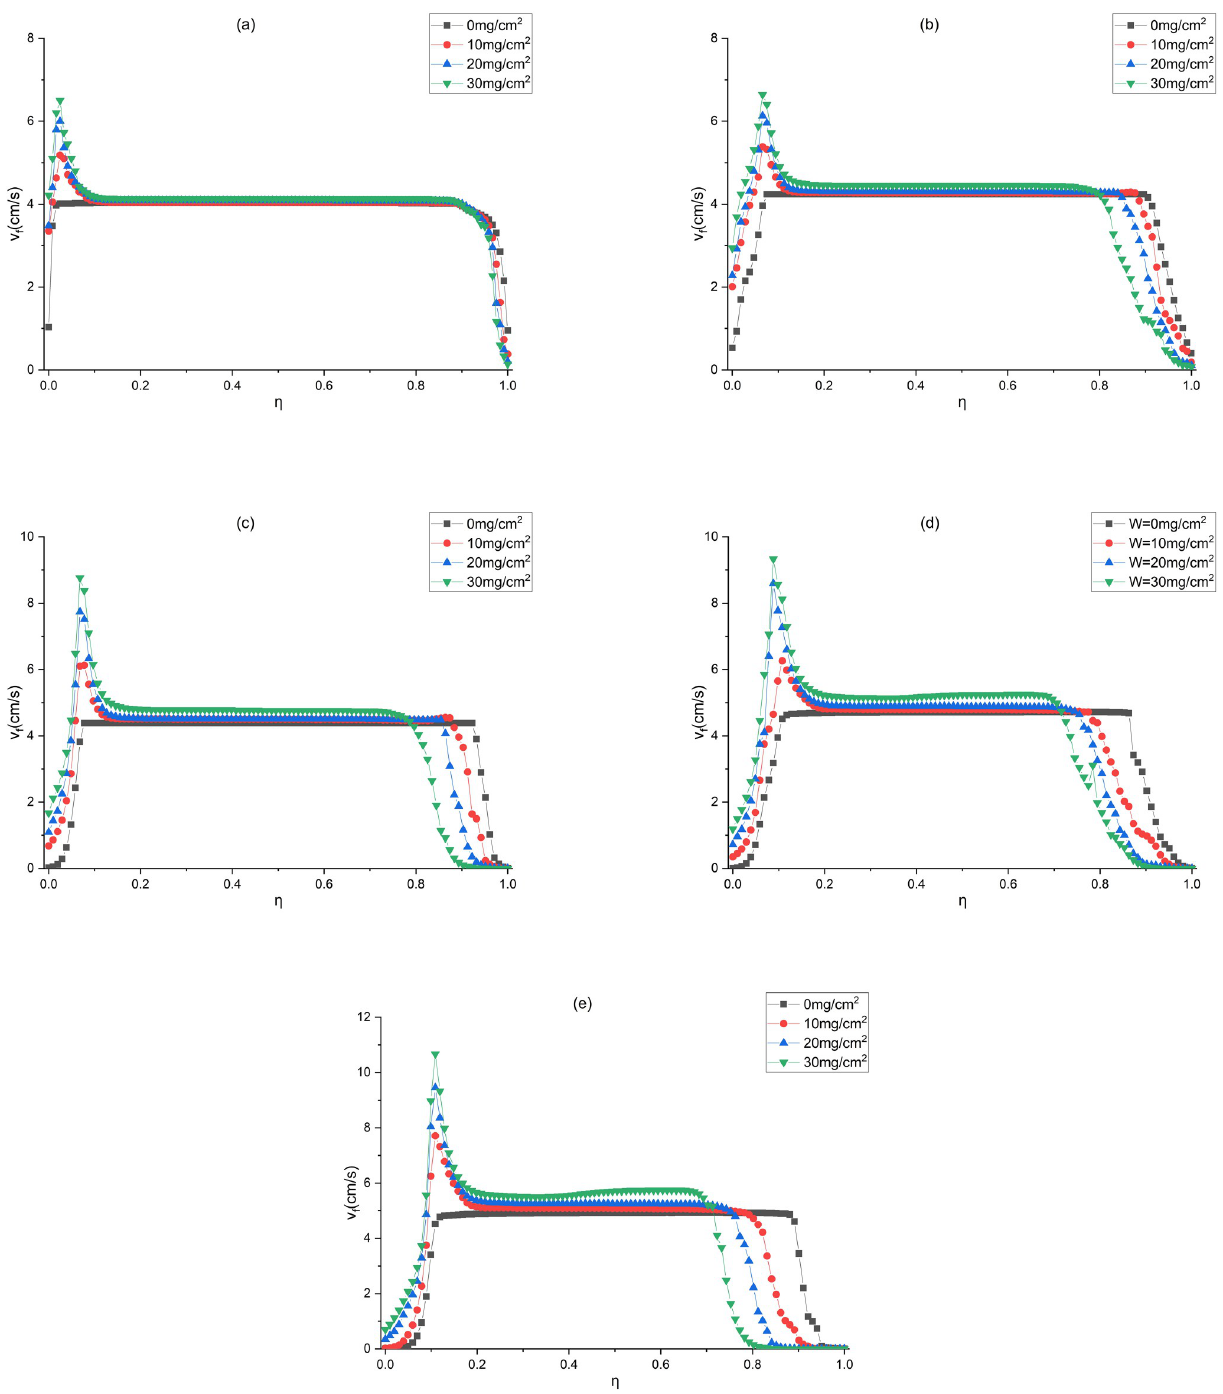
Fig 16. Changes in the NAVFs of the V-shaped filter during dust loading (a) α = 0.71, (b) α = 1.43, (c) α = 2.14, (d) α = 2.86, (e) α = 3.57.